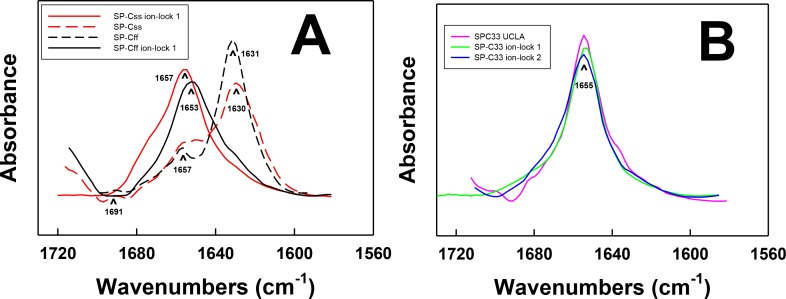
FTIR spectra of the amide I bands for SP-C mimic peptides in surfactant lipids (DPPC:POPC:POPG 5:3:2).(A) SP-Css is the dashed red line, SP-Css ion-lock 1 is the solid red-line, SP-Cff is the dashed black line and SP-Cff ion-lock 1 is the solid black line. The spectra for either SP-Css or SP-Cff in surfactant lipids with 10 deuterated mM phosphate buffer (pD 7.4) principally show β-sheet, with a major peak at 1630–1631 cm−1 and a very low companion peak at ∼1691 cm−1. The SP-Css and SP-Cff spectra also show significant shoulders at ∼1653–1657 cm−1, indicating minor α-helical structures. The corresponding spectra for SP-Css ion-lock 1 and SP-Cff ion-lock 1 in surfactant lipids primarily show α-helix with maxima at ∼1653–1657 cm−1, indicating that incorporation of the Glu−–Lys+ ion-pair in either SP-C mimic effectively reverses their β-sheet properties. (B) SP-C33 UCLA is a solid magenta line, SP-C33 ion-lock 1 is a solid green line, and SP-C33 ion-lock 2 is a solid blue line. The spectra for SP-C33 UCLA and the SP-C33 ion-locks in lipids all closely overlap, with shared maxima at ∼1655 cm−1 indicating predominate α-helix. The introduction of a single or double Glu−–Lys+ ion-pair in SP-C33 does not raise the α-helical levels over that seen with the parent SP-C33 UCLA (Table 1). Peptide concentrations were 470 μM, and sequences are in Fig. 1. FTIR spectra for peptide in lipid mixtures (Figs. 2A and 2B) were obtained by subtracting the lipid spectrum hydrated with 10 mM deuterated phosphate buffer (pD 7.4) from those of peptides in lipid with 10 mM phosphate buffer (pD 7.4).